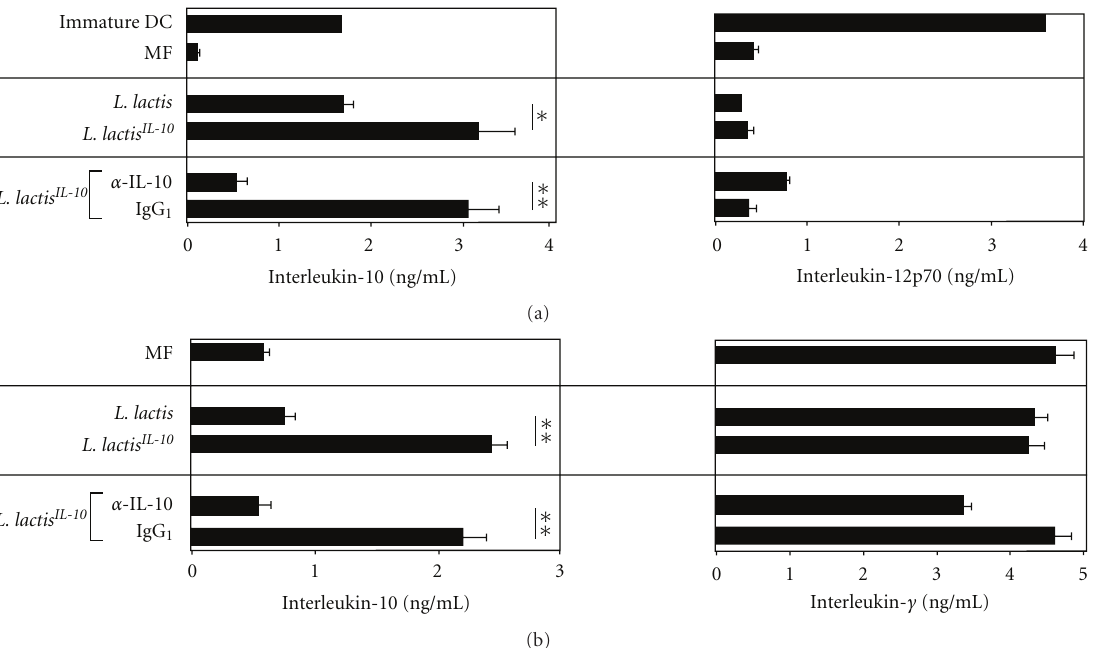
Figure 4: (a) Depicted is the cell cycle progression of allogenic Th-cells cocultured with MF-derived e ff ector Th-cells (white histograms, reference condition) and of allogenic Th-cells cocultured with e ff ector Th-cells when no α -IL-10 was added (no α -IL-10), α -IL-10 during DC-na¨ıve T-cell ( α -IL-10 DC-T) coculture or α -IL-10 during e ff ector T-cell and allogenic T-cell ( α -IL-10 T-T) coculture (gray histograms). (b) Bar graphs represent the mean inhibition of fluorescence intensity of allogenic Th-cells for the indicated conditions in triplicate. The proliferation of allogenic Th-cells cocultured with e ff ector Th-cells induced by MF-matured DC is regarded as 100% (reference condition). For transwell experiments, 2 × 10 6 PKH-labeled test cells were put in the upper compartment of a 24-well plate transwell system. Mean percentages with standard error of mean are given; ∗∗ indicates P < 0 . 01 using the χ 2 -test for comparing percentages with the reference condition ( α -IL-10 DC-T and transwell, resp.).